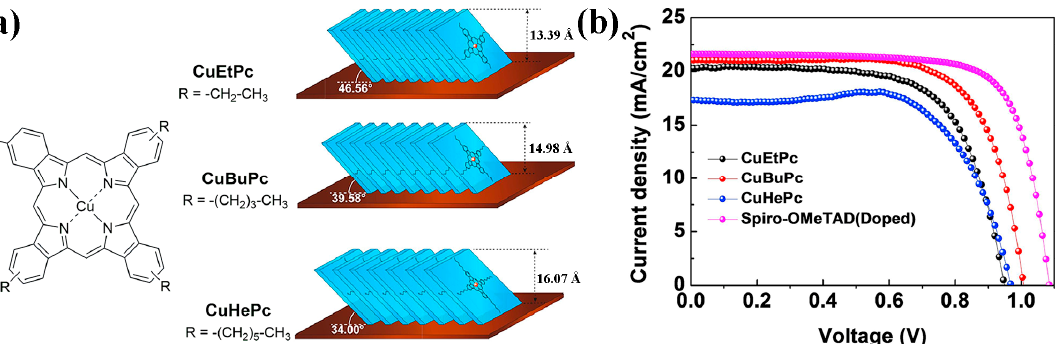
Figure 6. ( a ) Molecular orientation models for Pcs with di ff erent alkyl chains deposited on FTO/SnO 2 /perovskite. ( b ) J - V curves of PSCs with di ff erent HTMs. Adapted with permission from Ref. [101]. Copyright 2019 Elsevier.